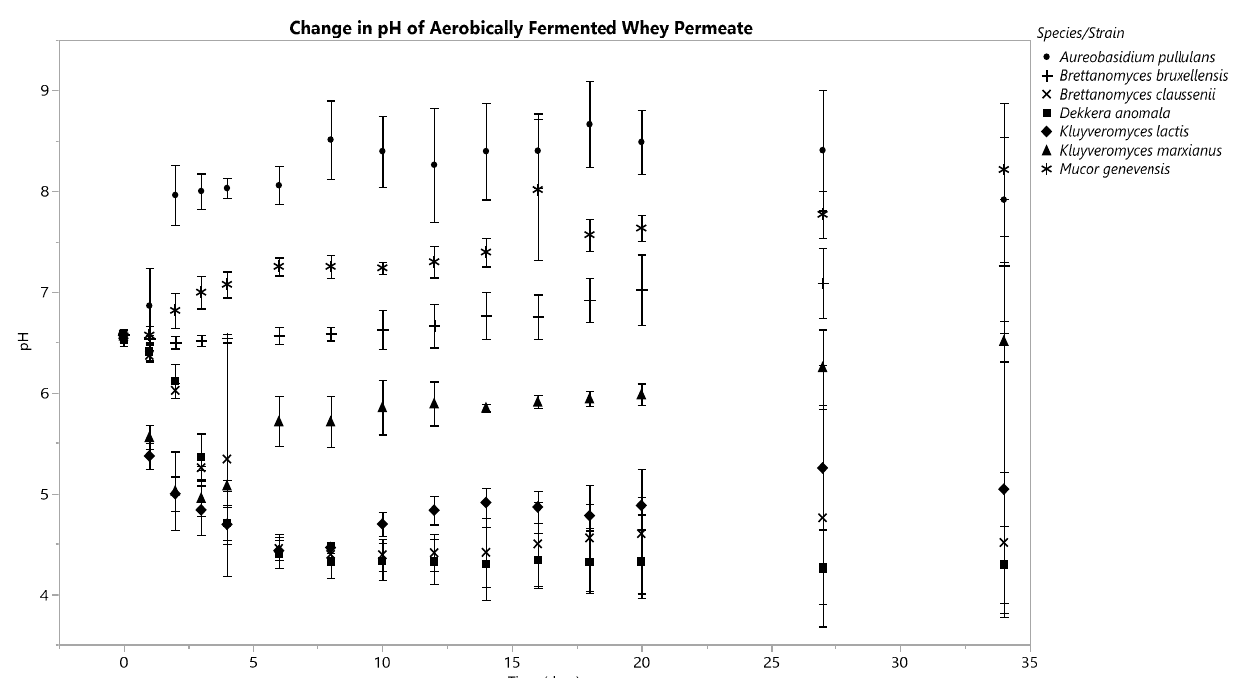
Figure 4. Means are represented by data points and standard deviations by error bars, which were calculated from three replicates for each species.